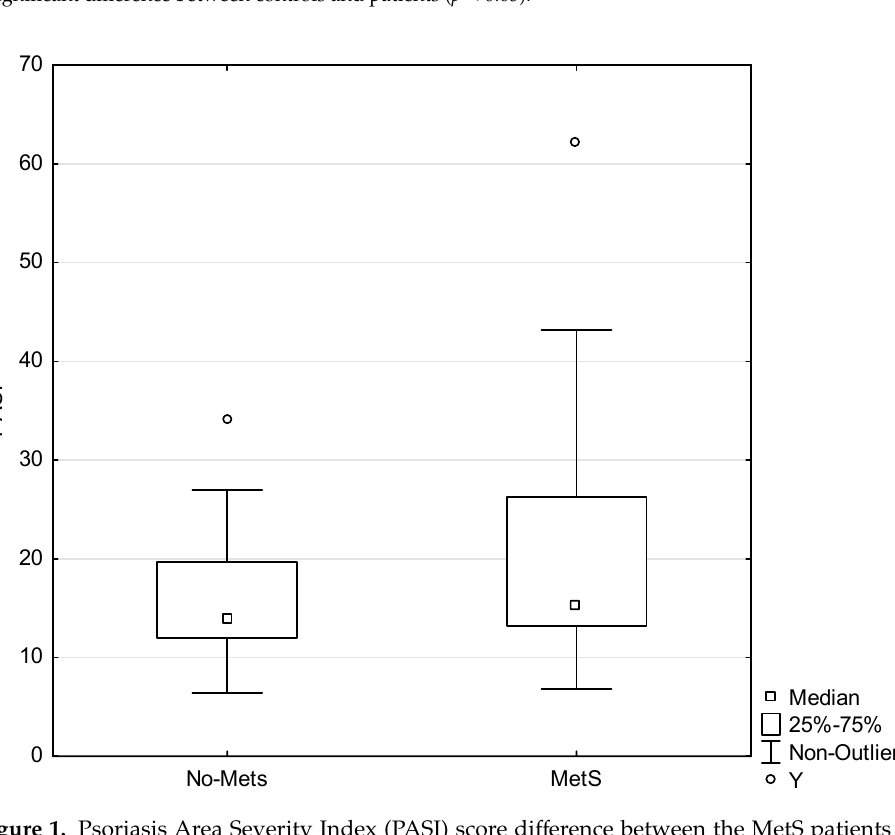
Figure 1. Psoriasis Area Severity Index (PASI) score difference between the MetS patients and the no-MetS patients. Y indicates an outlier. An outlier is any data point value > 75th percentile + 1.5 * (75th percentile–25th percentile) or any data point < 25th percentile–1.5 * (75th percentile–25th percentile), p < 0.05.